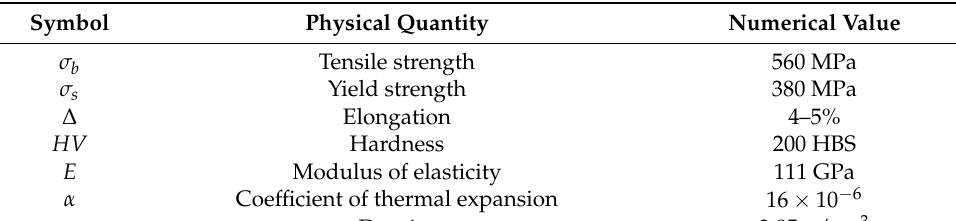
Table 1. Table of physical property parameters of SiCp/Al.